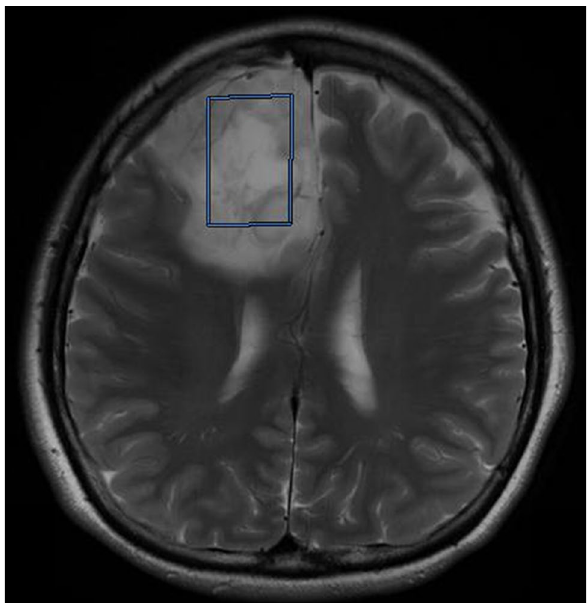
Figure 2. An MRI image showing an example of setting the voxel of interest in this